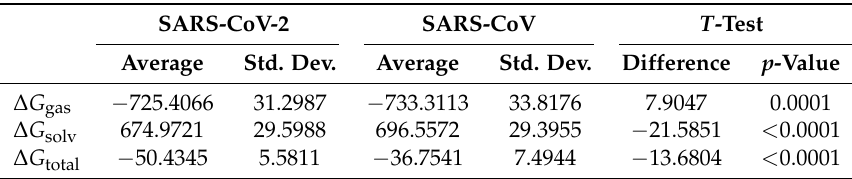
Table 1. The binding free energies calculated from molecular dynamics (MD) simulations for the RBD-ACE2 interactions of SARS-CoV-2 and SARS-CoV, where ∆ G gas is the interaction energy change in the gas and ∆ G solv is the solvation energy change upon binding in the solvent, respectively. All units are reported in kcal/mol. The t -test was conducted to check the statistical significance of the difference between two sets of free energies. A p -value of <0.05 indicates that the difference is statistically significant (95% confidence interval).